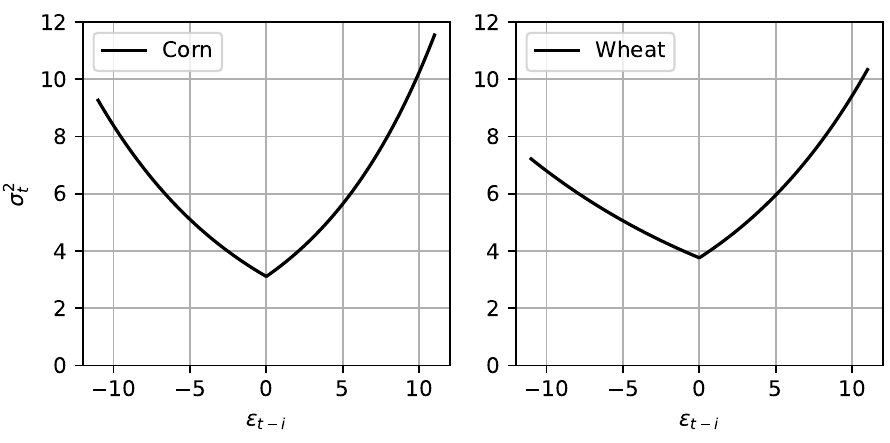
Figure 7. News impact curves from the estimated EGARCH models for corn ( left ) and wheat ( right ) returns. The time trend is evaluated at T = 50.